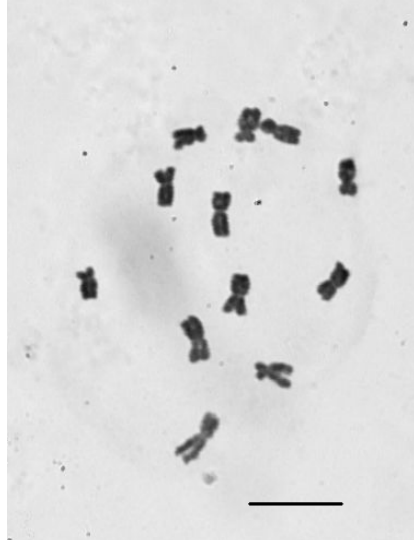
Figure 3. Root-tip mitotic metaphase chromosomes of E. sagittatum 2 n = 2 x = 12 are shown. Scale bar = 5